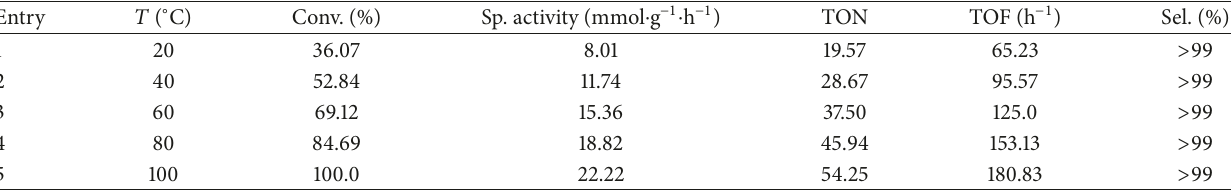
Table 3: Effect of reaction temperature on the oxidation of 1-phenylethanol using 1% ZnO 𝑥 –MnCO 3 as the catalyst. [ a ]